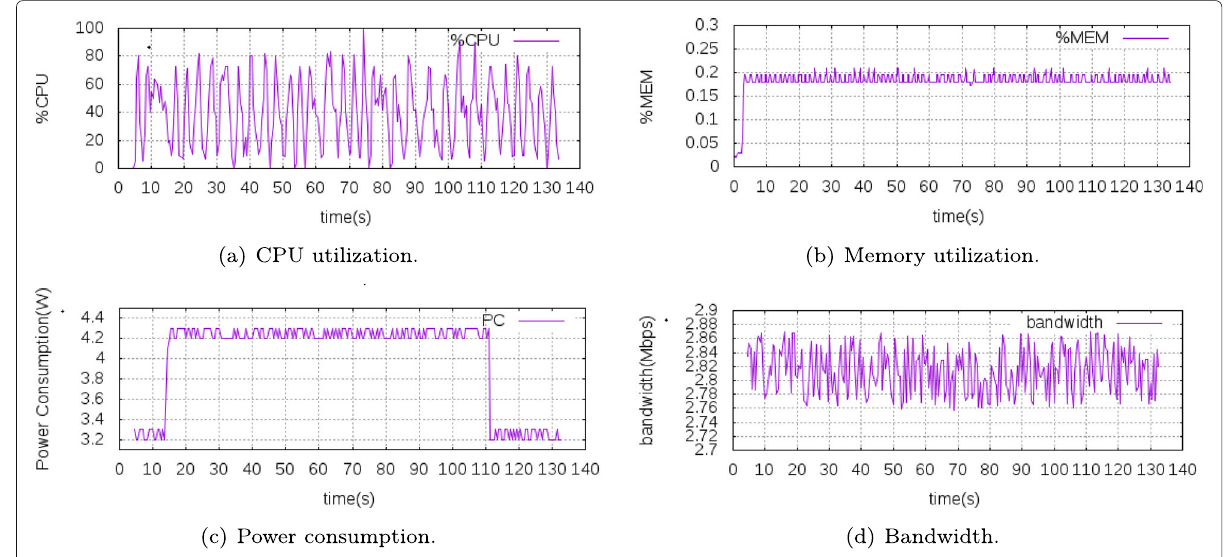
Fig. 7 System performance